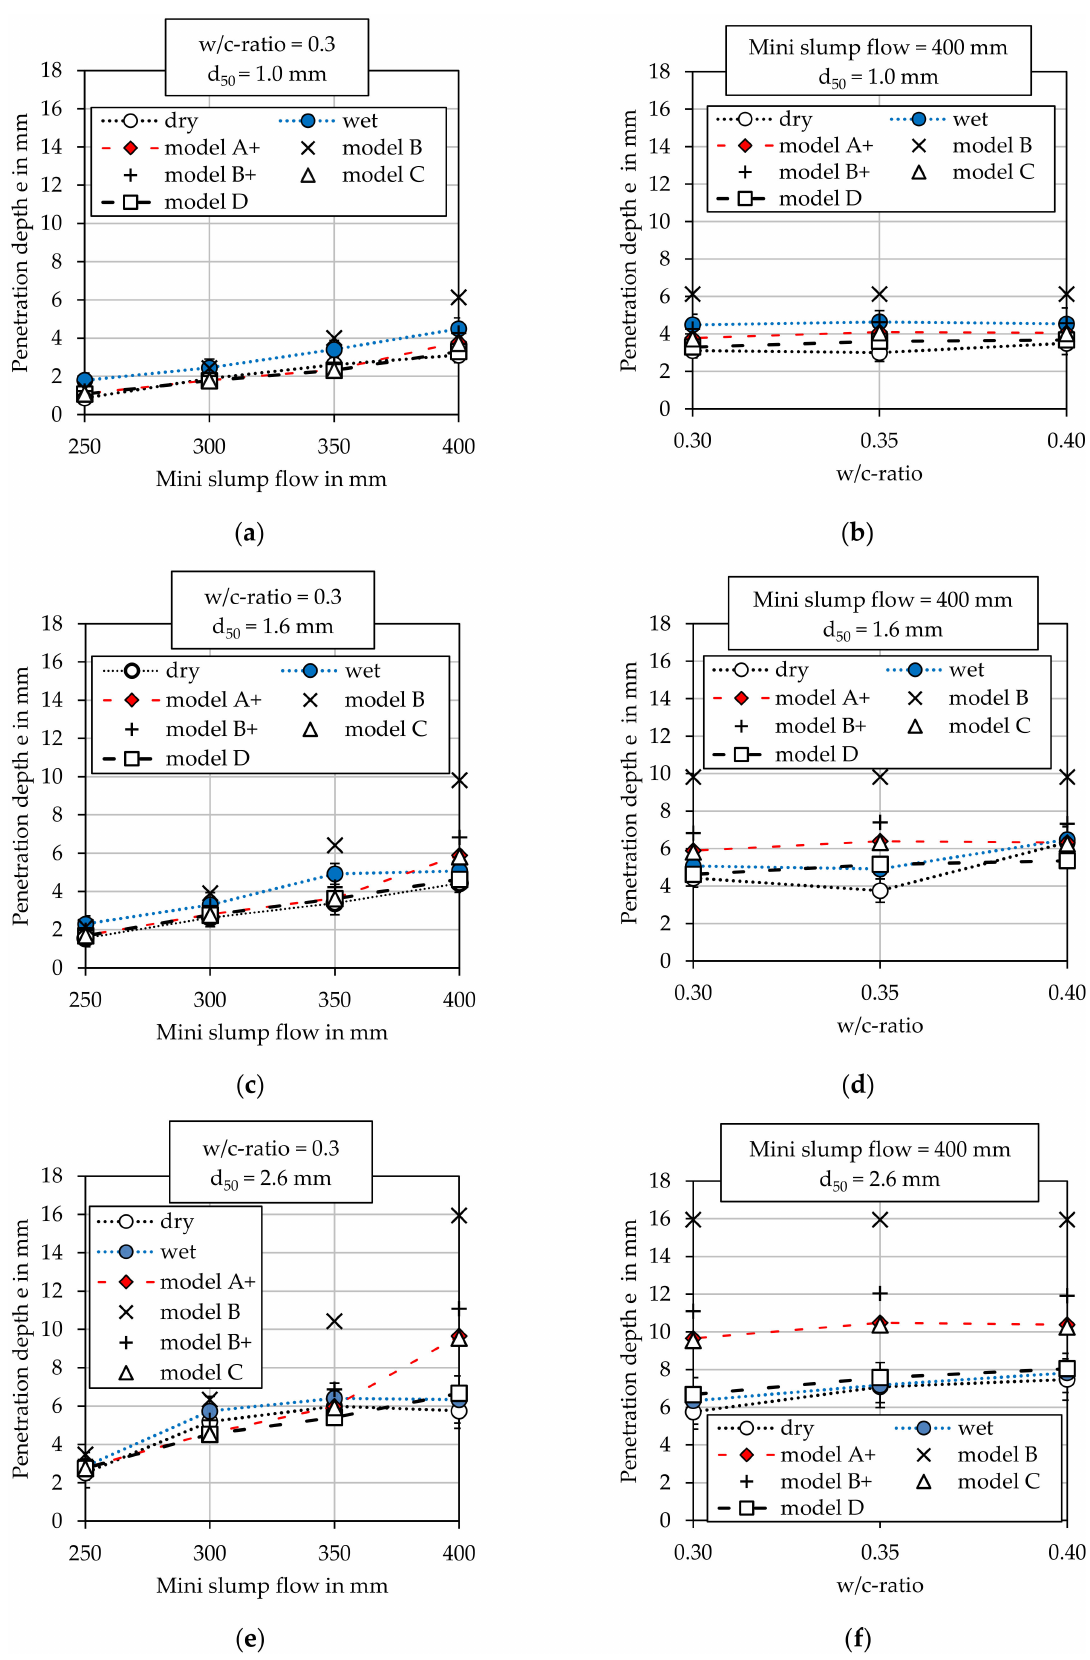
Figure 13. Measured and calculated penetration depths e (model C and D using tetrahedral gaps) depending on the mini slump flow ( a , c , e ) and on the w/c-ratio ( b , d , f ) as well as on the aggregate size (d 50 ) and humidity of the aggregate (wet and